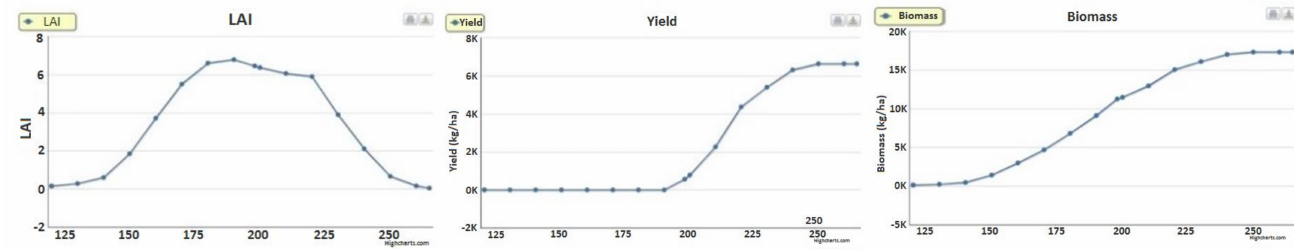
Figure 15. Prediction results of the crop growth model.